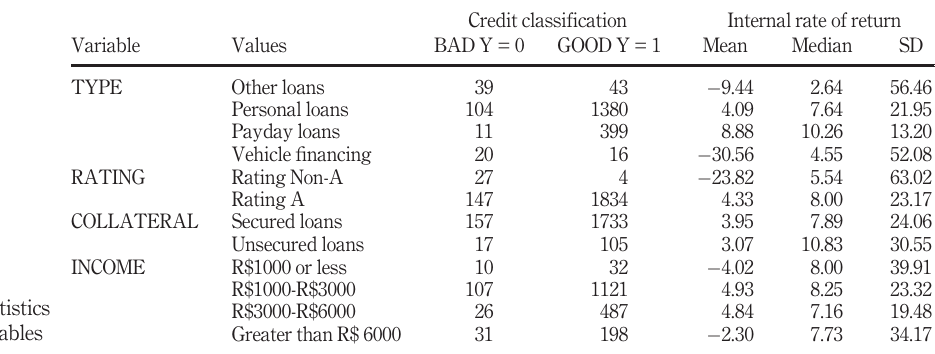
Figure 2. Histogram of the internal rate of return